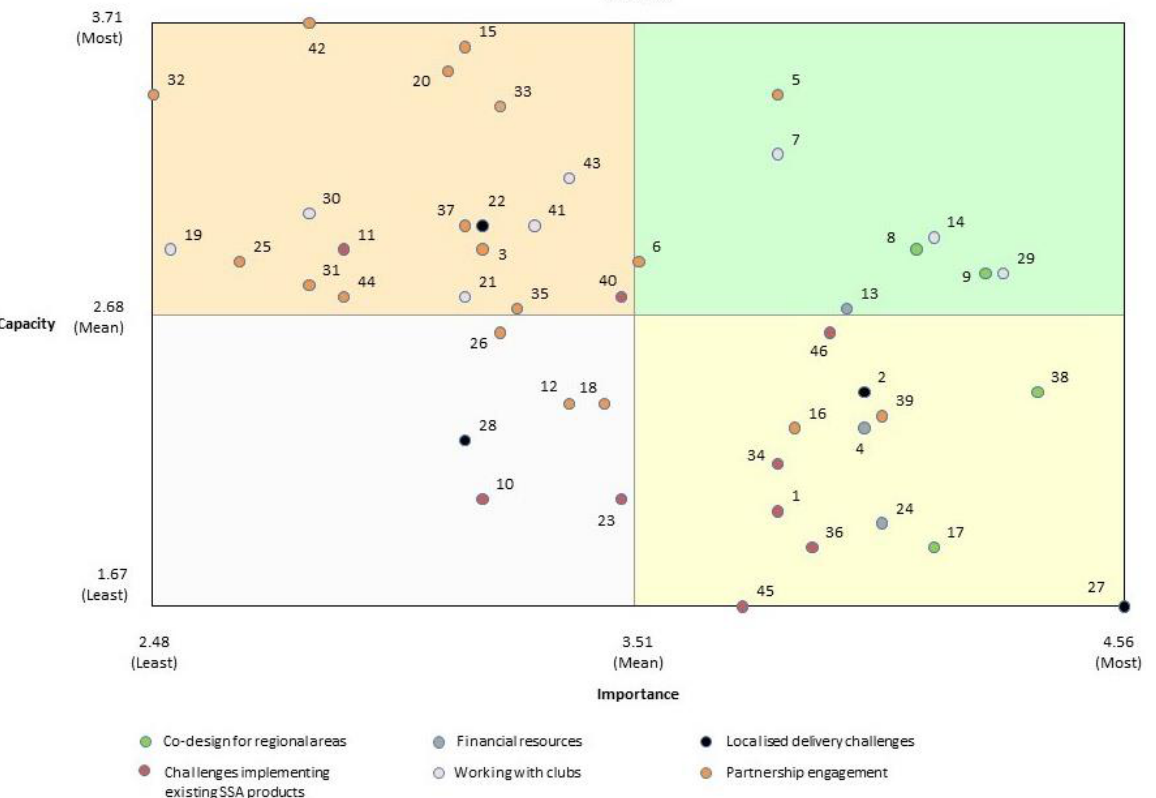
Figure 3. 6 Cluster map of challenges to working in partnership to promote physical activity in community sport settings. Figure 4 is a go-zone graph for all 46 challenges. The top right “go-zone” quadrant of